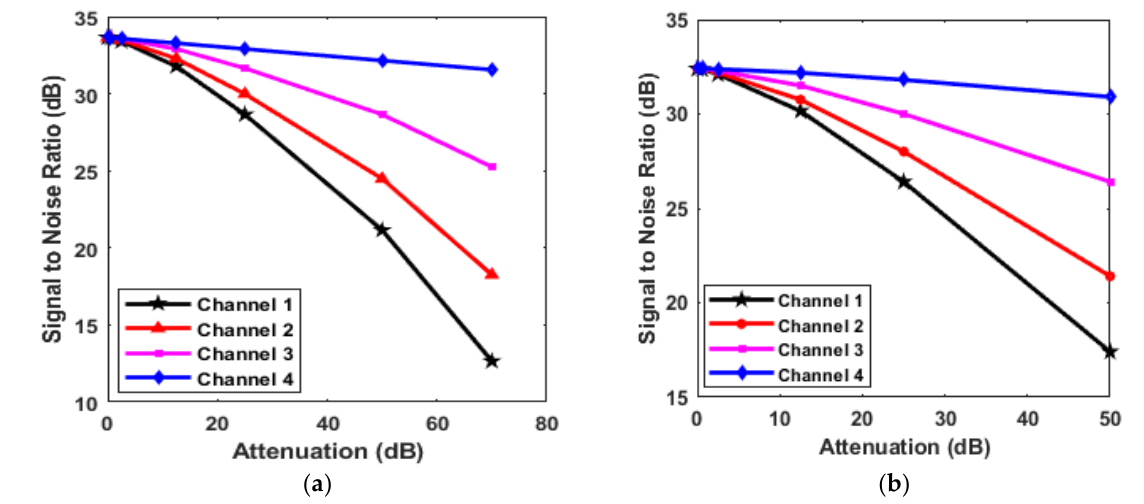
Figure 7. Signal-to-noise ratio versus attenuation ( a ) at 1 GHz bandwidth and ( b ) at 4 GHz band- width.